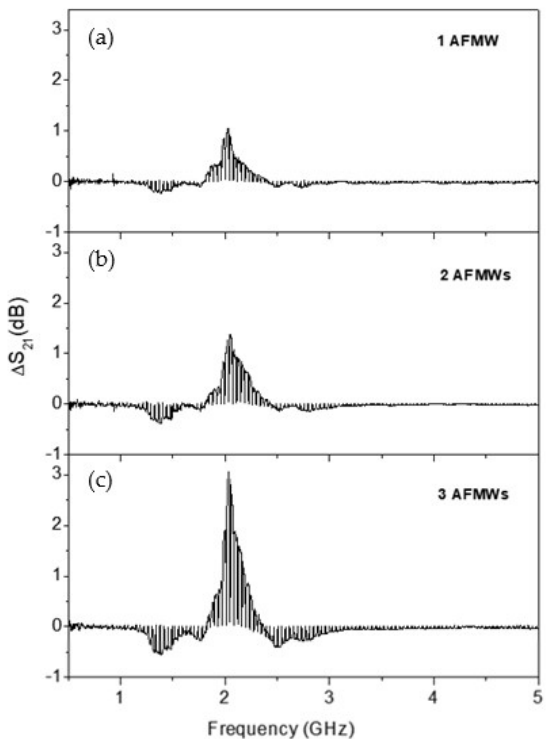
Figure 5. Modulation of the scattering coe ffi cient, ∆ S 21 versus frequency for three di ff erent cases: ( a ) 1 AFMW, ( b ) 2 AFMWs and ( c ) 4 AFMWs. All of them have 6 cm length and the separation was kept to 6